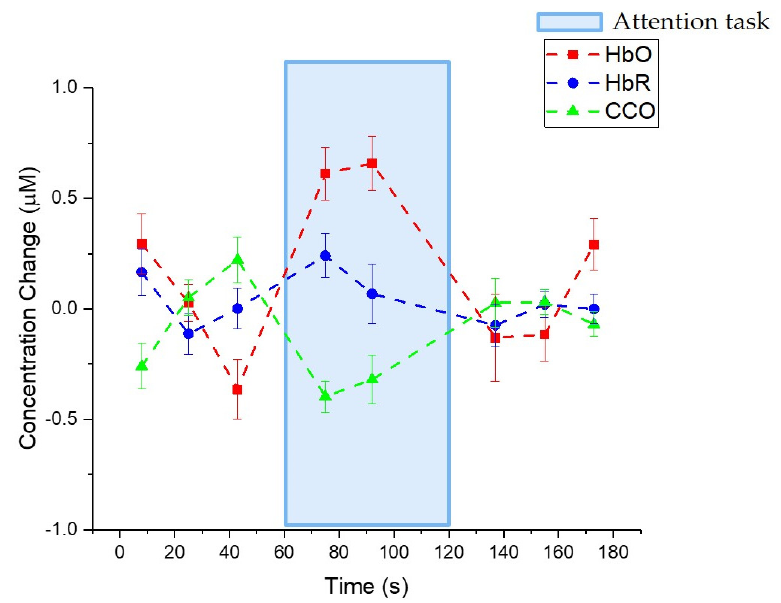
Figure 19. Using the “HbO increasing” screening, average of the change in HbO, HbR, and the redox state of CCO during the attention test. The error bars indicate the standard error.